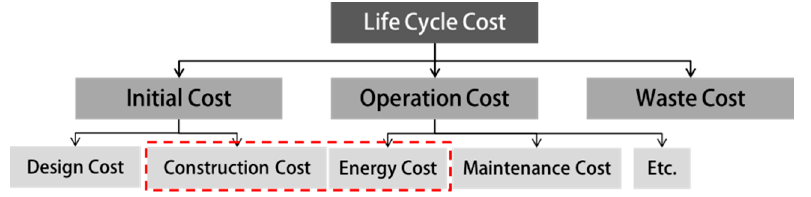
Figure 1. Scope of the Life Cycle Cost Analysis.